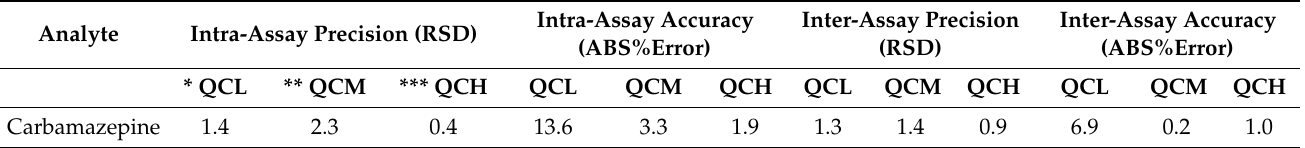
Table 3. Intra- and inter-assay ( n = 3) precision and accuracy obtained for carbamazepine.